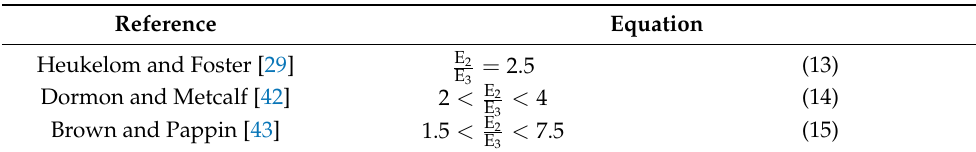
= k according to global literature. E 3